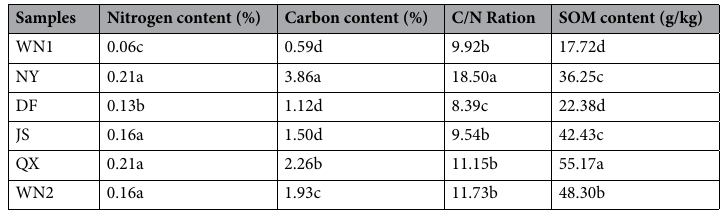
Table 1. The nitrogen, carbon, and SOM contents of soil samples collected in six sites. Different lowercase (a, b, c, d) represent significant differences at P < 0.05.